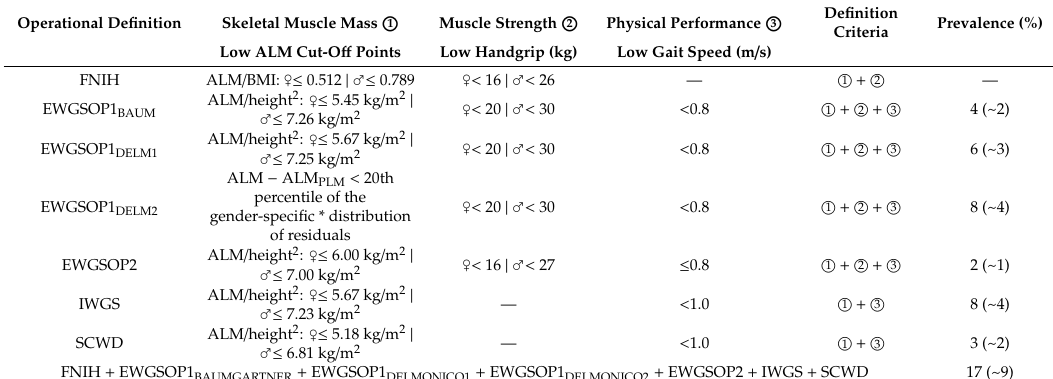
Table 2. EWGSOP = European Working Group on Sarcopenia in Older People; IWGS = International Working Group on Sarcopenia; SCWD = Society of Sarcopenia, Cachexia and Wasting Disorders; FNIH = Foundation for the National Institutes of Health Biomarkers Consortium Sarcopenia Project; ALM = Appendicular lean muscle mass calculated by summing lean muscle mass of upper and lower limbs; ALM / BMI = ALM adjusted by BMI; ALM / height 2 = ALM adjusted by height squared; * ALM PLM = gender-specific predicted linear model of ALM following ALM linear regression by height and total body fat